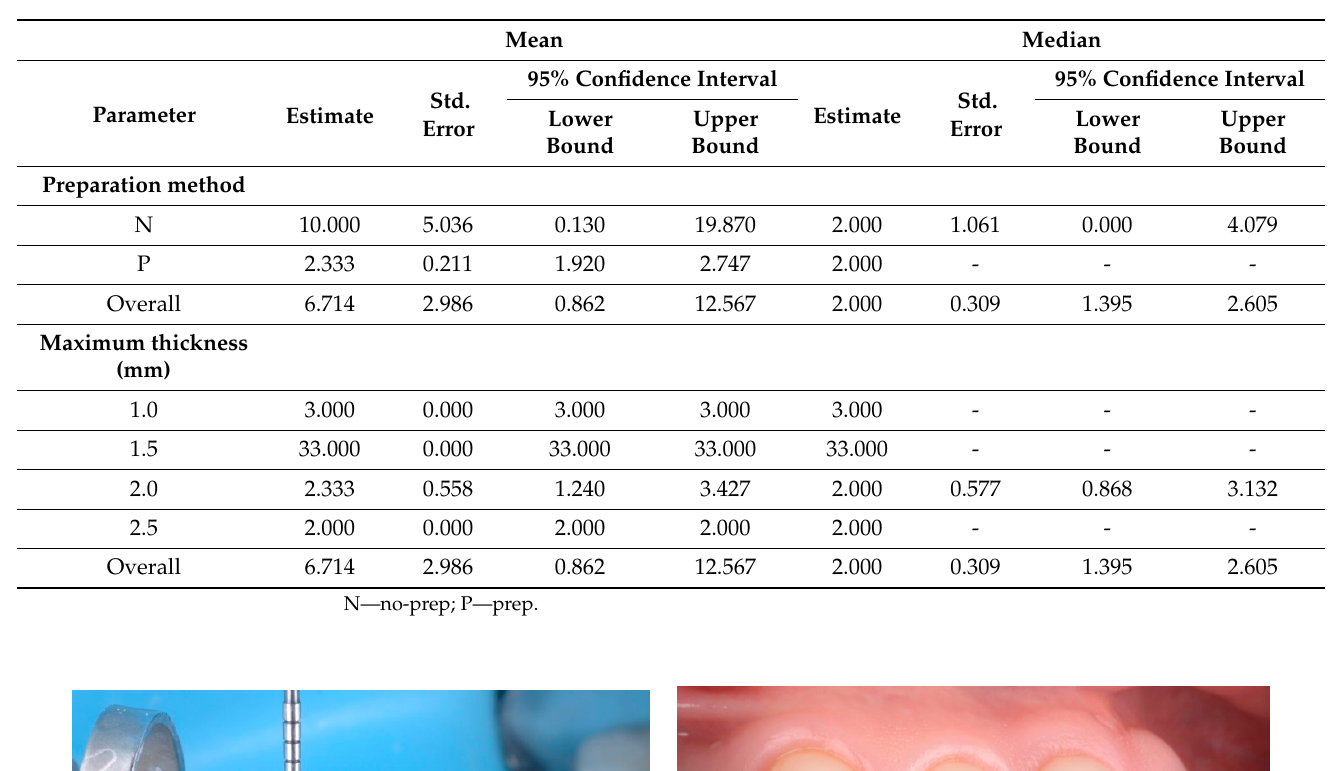
Table 4. Means and medians for survival time (in months), based on the preparation method and the maximum thickness of the veneers.